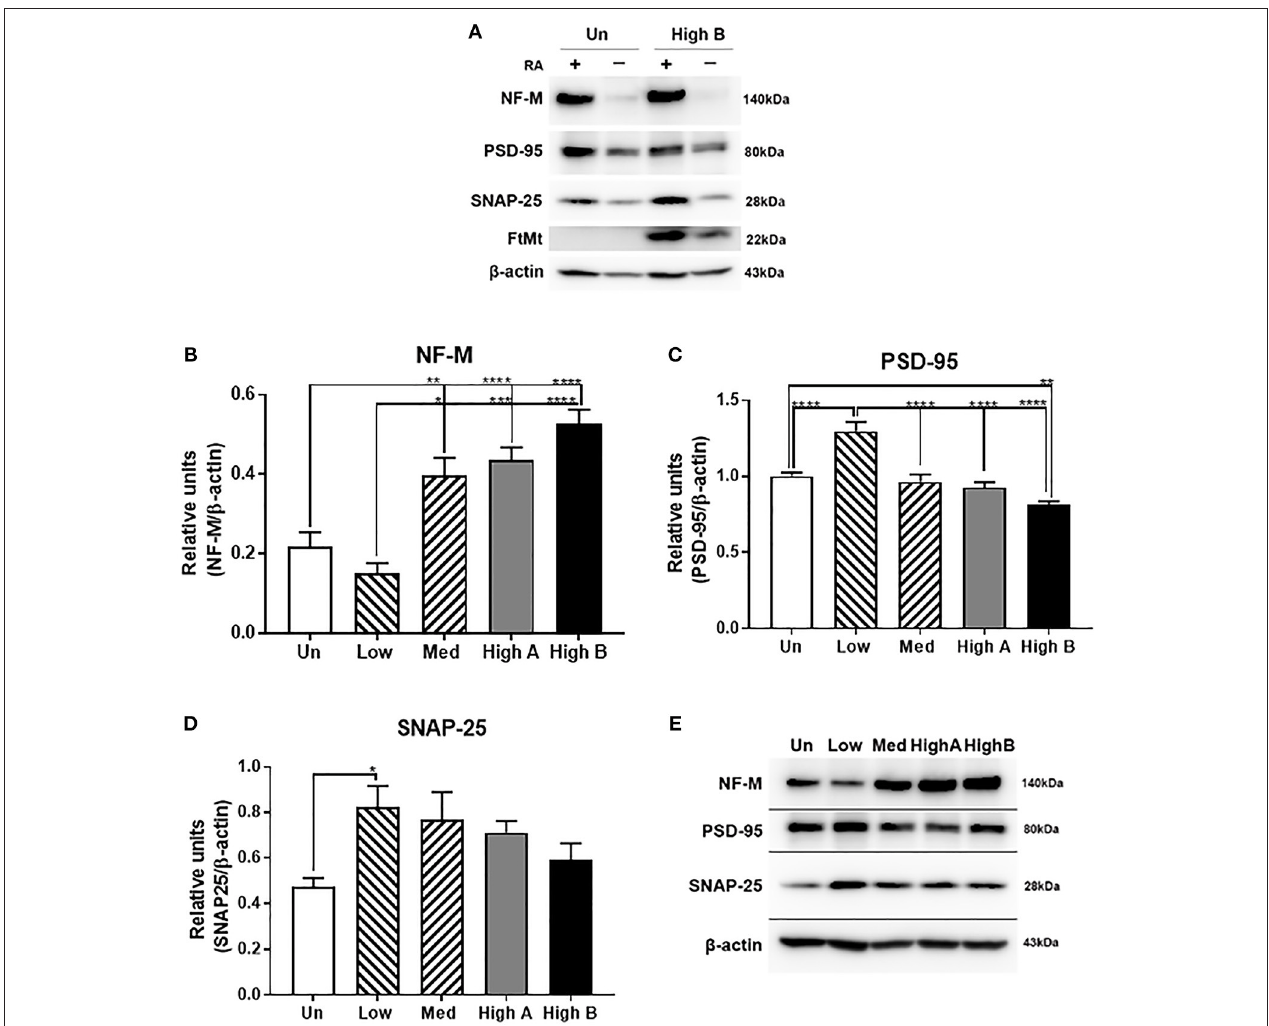
FIGURE 4 | Expression of neuronal proteins in FtMt clones. (A) Composite picture of western blots showing the differences in levels of NF-M, PSD-95, SNAP-25, and FtMt between undifferentiated (-) and RA differentiated ( + ) of untransfected (Un) and FtMt high expressing clone (High B). It was noticed in all experiments that FtMt expression was increased with differentiation RA treatment, even though the expression vector was using the CMV immediate-early promoter, and not the native FtMt promoter. (B) Relative levels of NF-M (B) in different FtMt clones. Results shown in B represent mean ± SEM of triplicate experiments. Data analyzed by One way ANOVA with Tukey’s post hoc test of significance. Results indicate level of significance. * p < 0.05; ** p < 0.01, *** p < 0.001, **** p < 0.0001. (C) Relative levels of PSD-95 (C) in different FtMt clones. Results shown in C represent mean ± SEM of triplicate experiments. Data analyzed by One way ANOVA with Tukey’s post-hoc test of significance. Results indicate level of significance. * p < 0.05; ** p < 0.01, *** p < 0.001, **** p < 0.0001. (D) Relative levels of SNAP-25 (D) expression in different FtMt clones. Results shown in -D represent mean ± SEM of triplicate experiments. Data analyzed by One way ANOVA with Tukey’s post-hoc test of significance. Results indicate level of significance. * p < 0.05. (E) Composite Western blot showing pattern of expression for NF-M, PSD-95, and SNAP-25. Representative western blots of one experiment showing patterns of expression in untransfected and different FtMt clones. Experiment represents the